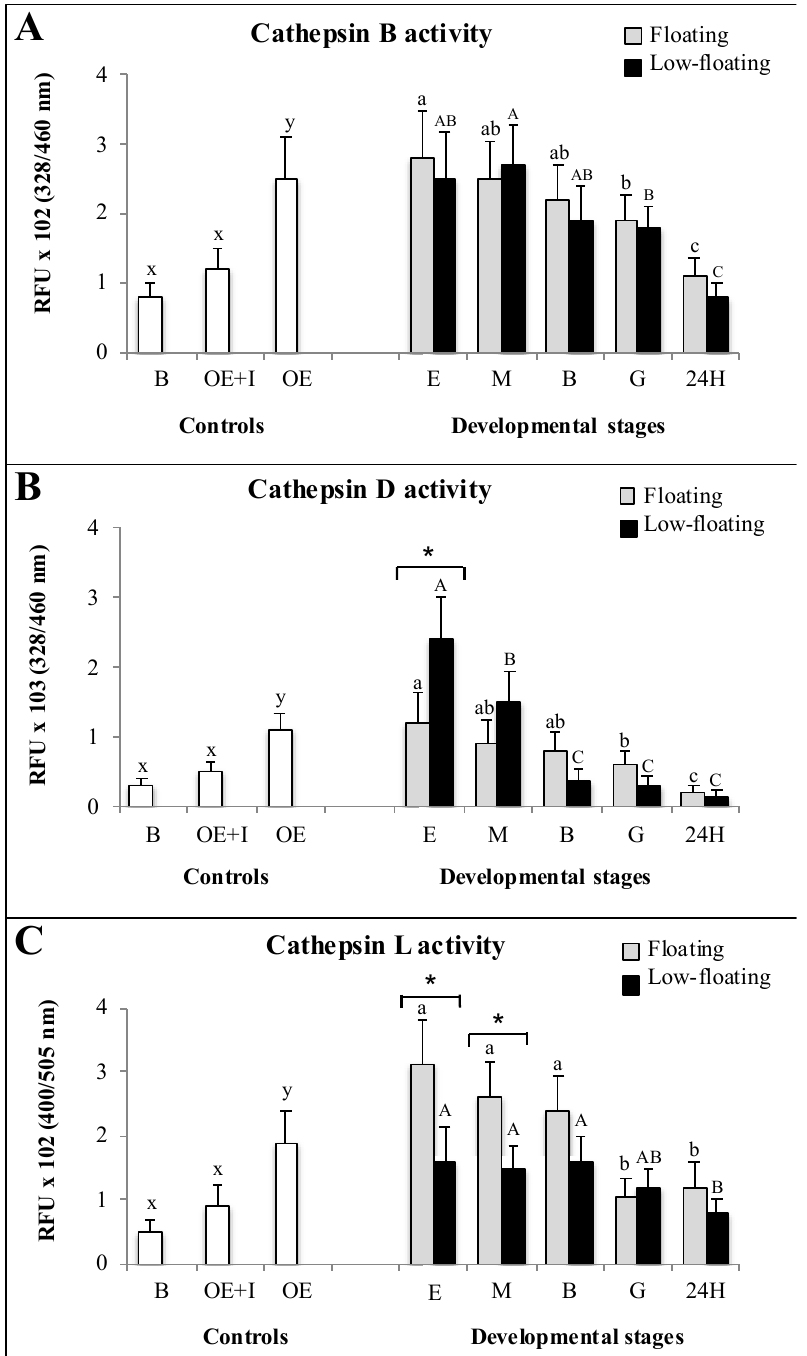
Figure 5. Enzymatic activity assays of cathepsins B ( A ), D ( B ) and L ( C ) throughout Seriola lalandi development in floating (gray bars) and low-floating (black bars) embryos. White bars represent control reaction samples in which negative controls with the reaction buffer were considered (RB). The specificity of reactions was determined by adding specific inhibitors to ovarian extracts (OE + I). Fertilized eggs, morula, blastula and 24 h post-fertilization embryos are identified as E, M, B, G and 24H, respectively. Bars represent mean ± standard deviation (SD) of six biologicals replicates, and different lowercase or uppercase letters indicate statistically significant differences within floating or and low-floating embryos, respectively ( p < 0.05). Differences between floating and low-floating embryos are identified with an asterisk over a bracket.